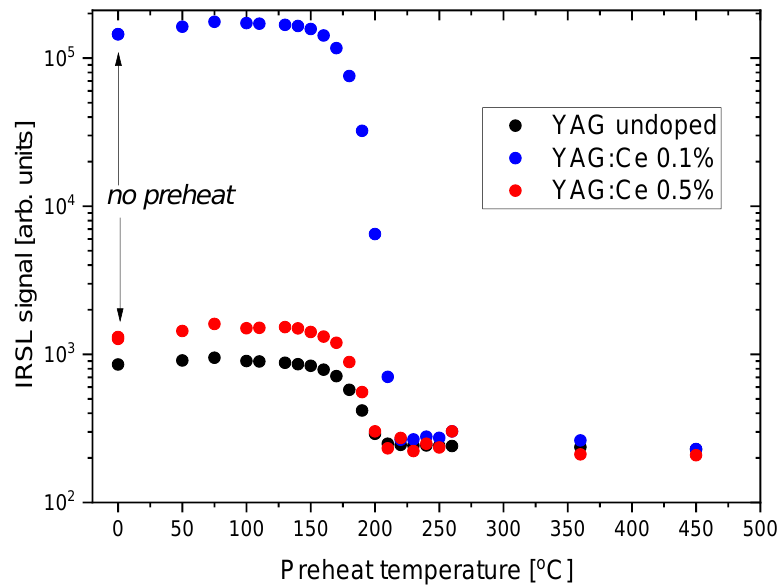
Figure 13. IRSL signal of YAG:Ce 0.1%, YAG:Ce 0.5 %, and undoped YAG crystals as a function of pre-heat temperature. The first data points represent no pre-heat. Dose 0.5 Gy.